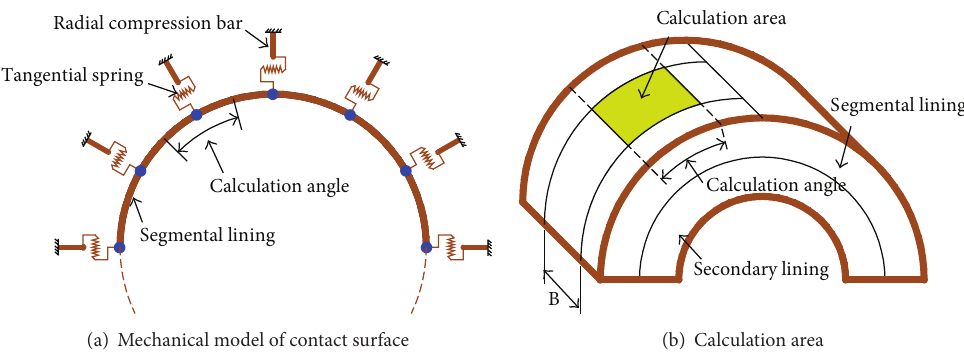
Figure 5: Schematic diagram of calculation model of contact face between segment and strata.